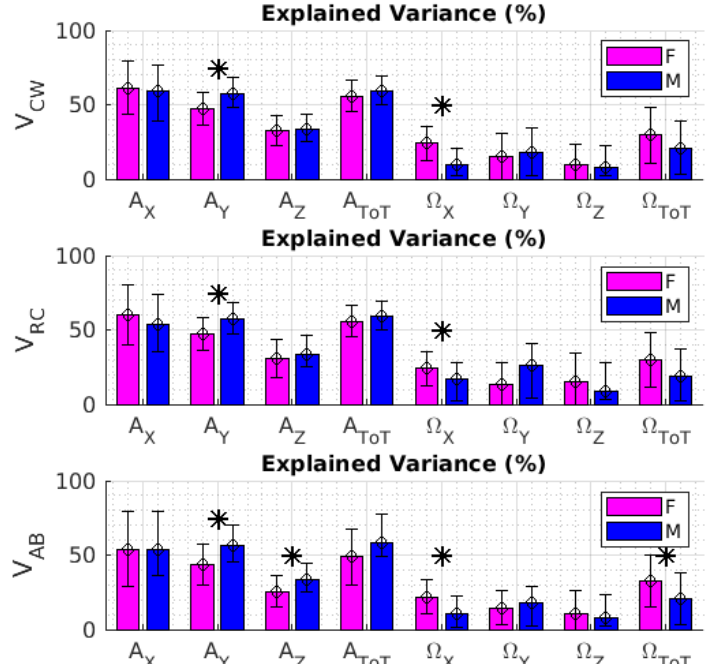
Figure 3. The three panels depict the variance explained by the best-matching retained PCs related to volumes V CW , V RC , and V AB , respectively. Bars and error bars respectively refer to mean and standard deviation of the explained variance across subjects. Data reported in magenta and blue refer to male and female. The label * represents the outcome of the unpaired t -test when significant (i.e., p < 0.05).